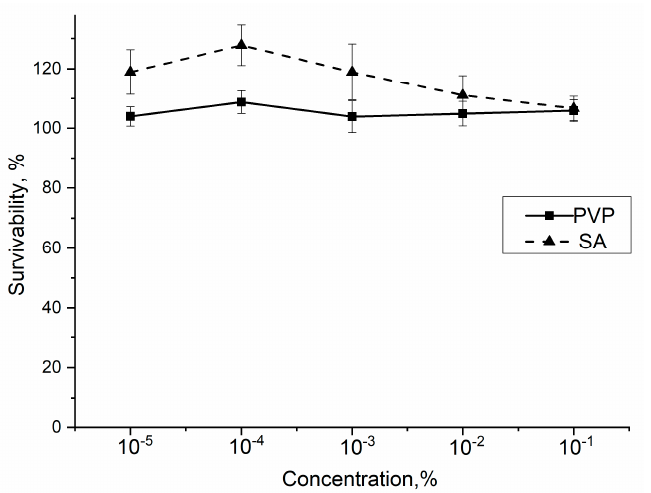
Figure 10. The viability of mouse fibroblast NCTC clone L929 upon addition of PVP and SA. The control sample corresponds to 100%. The statistical analysis of reliability was performed according to the Mann–Whitney U-test ( p ≤ 0.01).